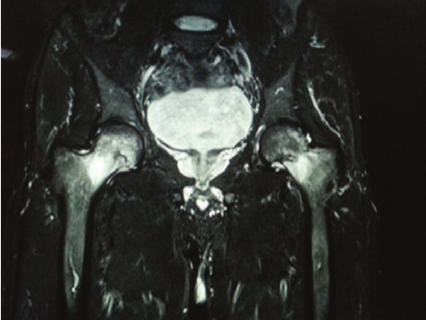
Figure 4: A T 2 weighted coronal magnetic resonance imaging (MRI) scan of pelvis with both hips showing oedema adjacent to the fracture line in the neck.